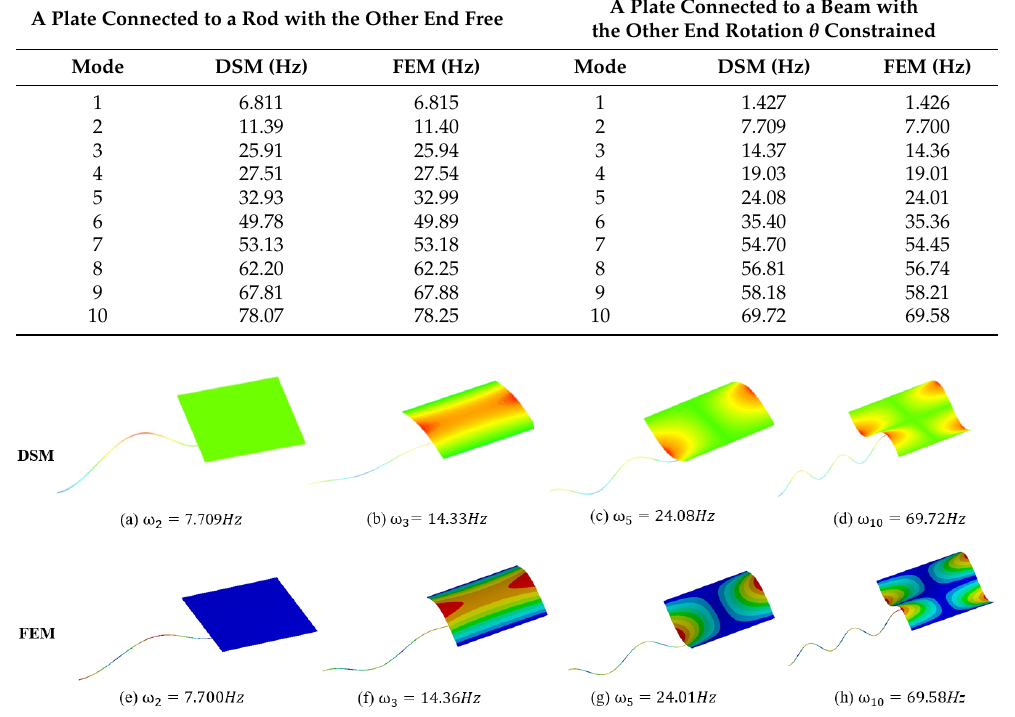
Figure 16. Comparison of representative mode shapes computed by both DSM and FE for a plate connected to a beam with the other end rotation θ constrained as shown in Figure